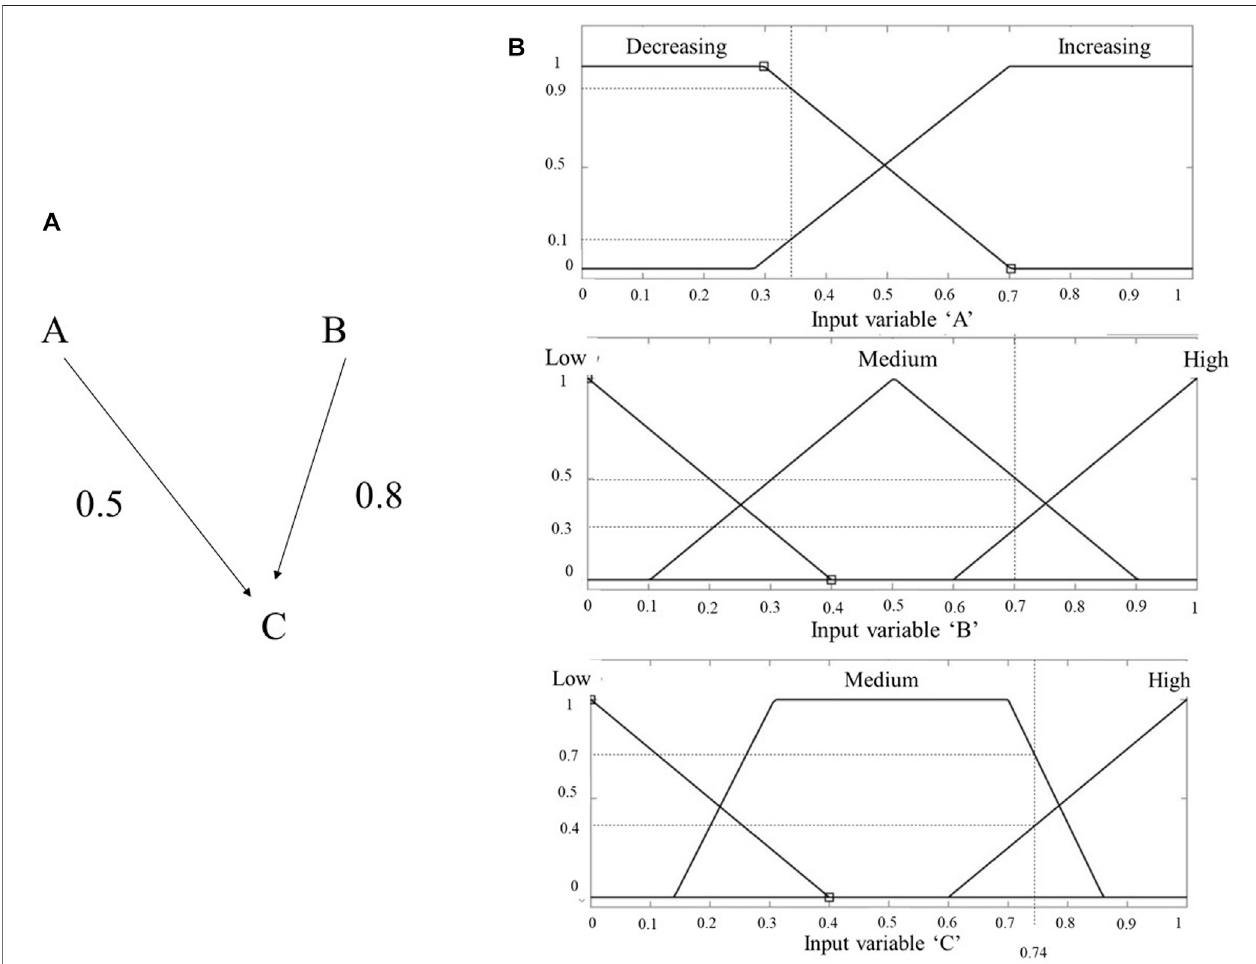
FIGURE 2 | (A) Simple example of FCMs with two variables A and B affecting the variable C. (B) Linguistic functions for variables A, B, and C.